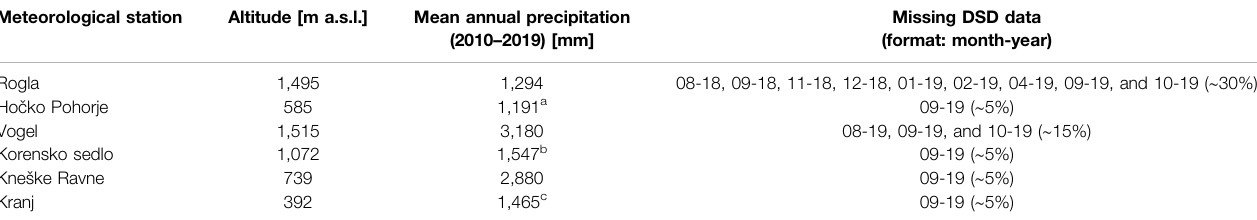
TABLE 1 | Main characteristics of the analyzed meteorological stations. DSD stands for drop size distribution. Meteorological station Altitude [m